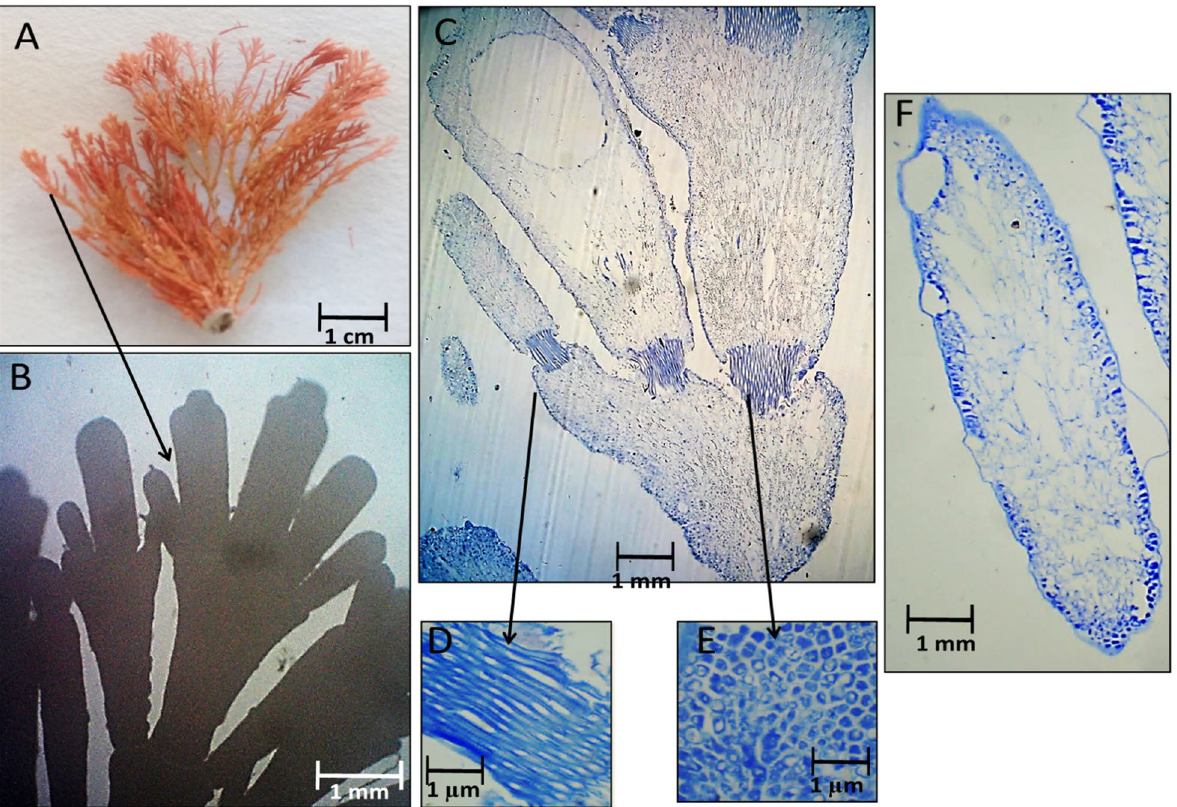
Fig. 5 Morphological and anatomical description of C. officinalis thallus during summer 2020. A Habit view of thallus, B Magnification of the thallus frond, C L.S. in thallus showing genicula and intergenicula tiers, D and E Magnification of mature geniculum, F Cross-section through intergeniculum